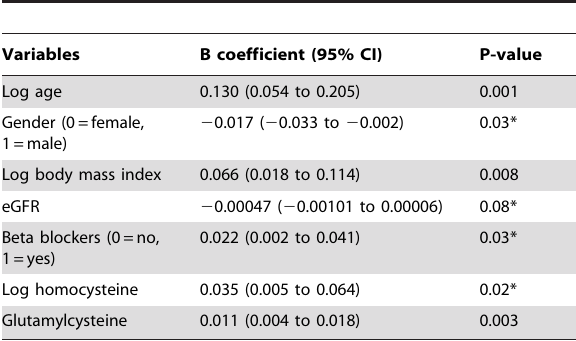
Table 3. Forward stepwise regression of serum ADMA